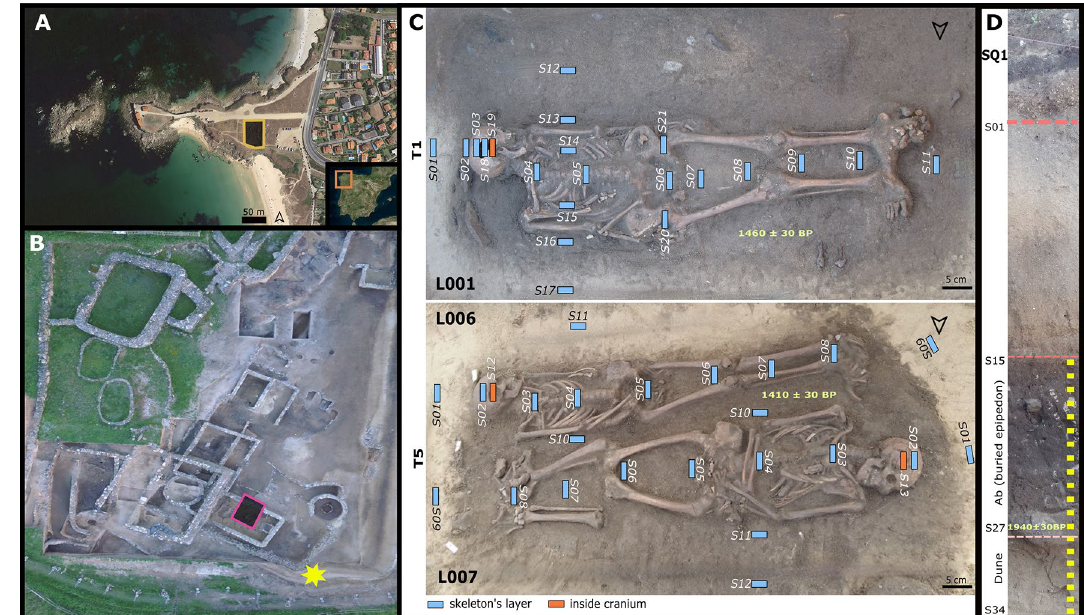
Figure 1. ( A ) and ( B ) Aerial view of A Lanzada with the burial area marked by a square and the location of the pedo-sedimentary sequence by a star in ( B ) ( A modified from 42 , https:// bit. ly/ 3FwpZ rE; B modified from 43 , https:// bit. ly/ 3BBqx Ky). ( C ) Sampling design of T1 and T5 burials (image by Aerorec S.L. & Deputación de Pontevedra modified from 44 ). ( D ) The pedo-sedimentary sequence and soil sampling (yellow dots; image by Aerorec S.L. & Deputación de Pontevedra modified from 44 ). Radiocarbon datings are included in ( C ) and ( B